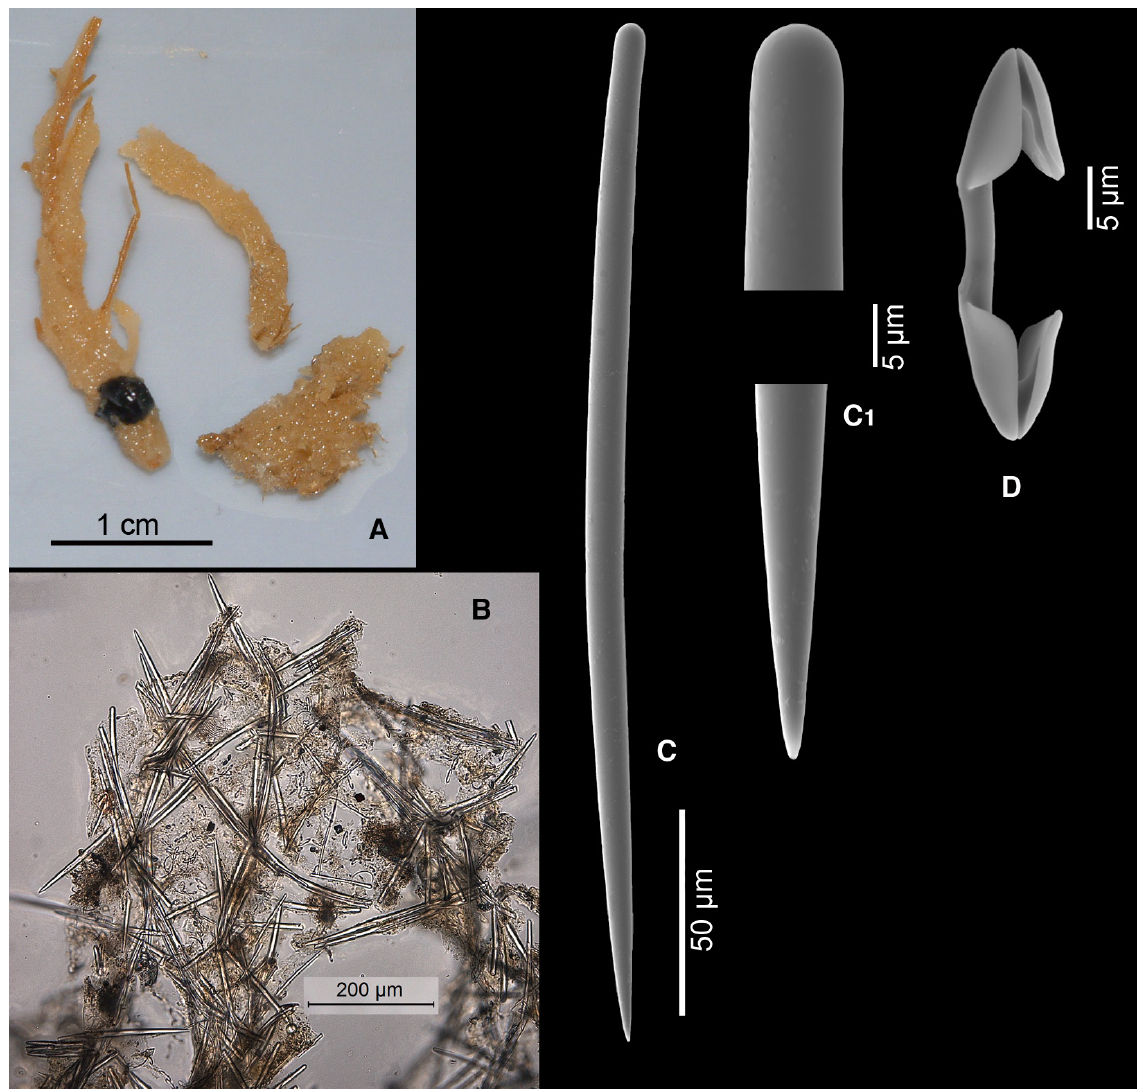
Fig. 5. Amphilectus fucorum (Esper, 1794), ZMA Por. 06775. A . Habit (fragments). B . Cross section of skeletal reticulation. C-D . SEM images of spicules. C . Style. C